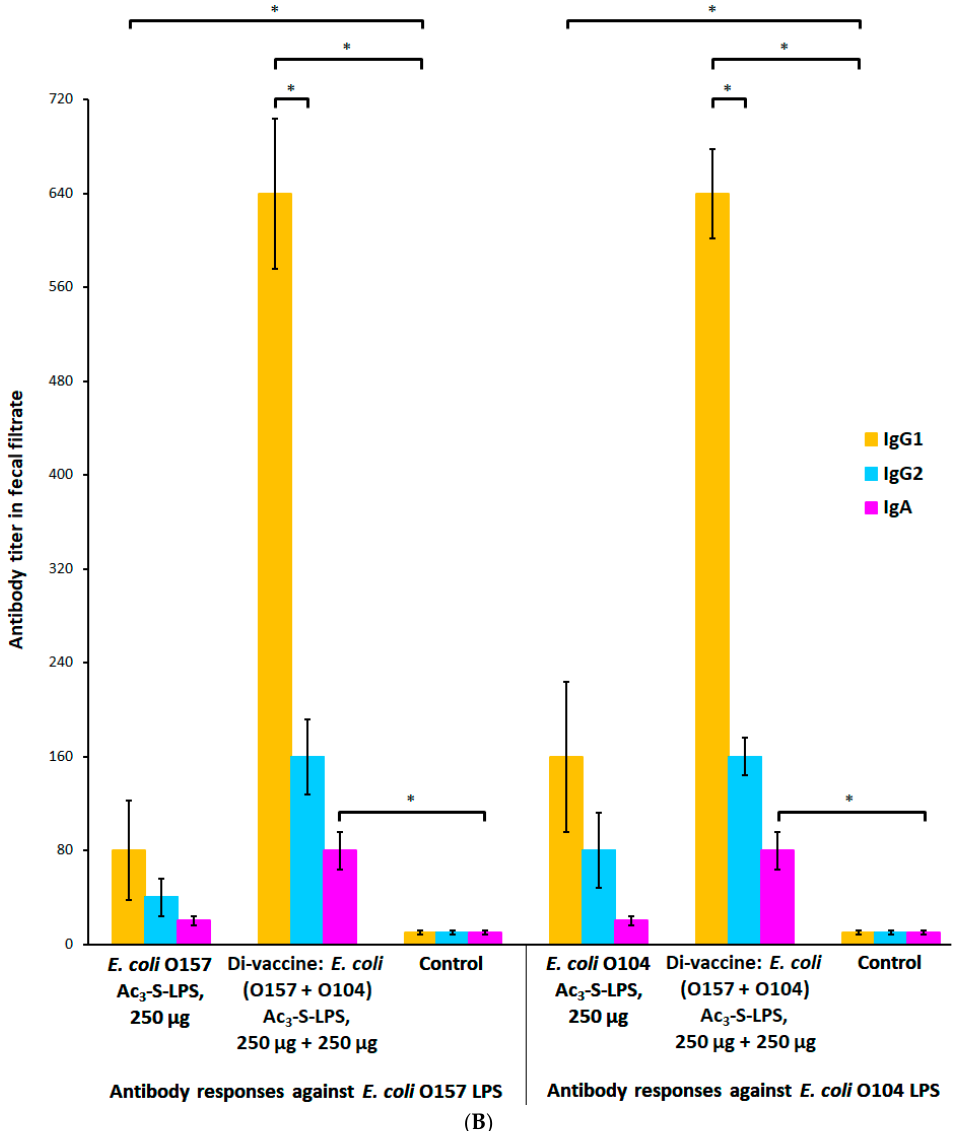
Figure 5. Systemic and mucosal humoral immune responses in mice after triple immunization with high dose of E. coli (O157 + O104) Ac 3 -S-LPS di-vaccine and its individual components. ( A ) Titers of specific IgG subclasses in sera increased in mice immunized i.p. three times with 250 µ g of each Ac 3 -S-LPS E. coli O157 or Ac 3 -S-LPS E. coli O104 antigen or with 500 µ g (250 µ g + 250 µ g) of di-vaccine. IgG1 was the dominant subclass in the sera. Differences between IgG1 and IgG2 titer increases were significant ( p < 0.05, ANOVA). Ac 3 -S-LPS preparations induced 128-fold and higher rises in serum O-specific IgG1-titers, and these rises were significant ( p < 0.05, ANOVA). Only di-vaccine elicited IgA response for both antigens in the sera and the increases in IgA titers over those in control sera were significant ( p < 0.05, ANOVA). ( B ) Titers of specific IgG subclasses in the feces increased in mice immunized i.p. three times with 250 µg of each Ac 3 -S-LPS E. coli O157 or Ac3-S-LPS E. coli O104 antigen or with 500 µg (250 µg + 250 µg) of di-vaccine. IgG1 was the dominant subclass in the feces. Differences between IgG1 and IgG2 titer increases were significant only for di-vaccine ( p < 0.05, ANOVA). Di-vaccine induced 64-fold rises in fecal O-specific IgG1-titers for both antigens and these rises were significant. Di-vaccine also elicited IgA response for both antigens in the feces, and the 8-fold increases in IgA titers over those in control feces were significant. The results shown are means ± SD. Significant difference between values are indicated (* p < 0.05, ANOVA).